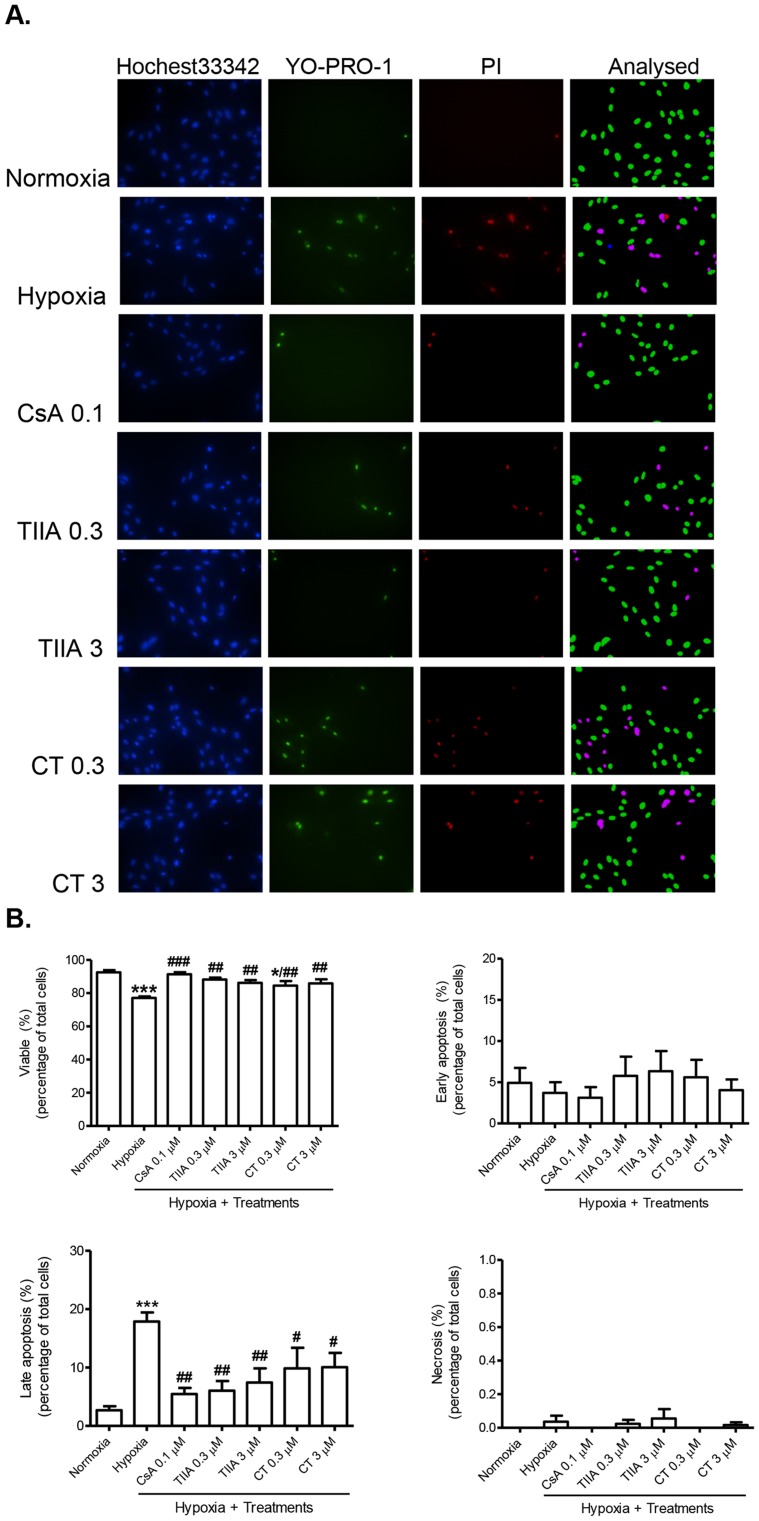
Effects of TIIA, CT and cyclosporin A (CsA) on hypoxia induced apoptosis. (A) Representative cell images from H9c2 cells staining with Hoechst 33342 (blue), YO-PRO-1 (green) and PI (red) as described in method. Analysed images show viable (green), early apoptosis (blue), late apoptosis (pink) and necrosis (red) cells respectively. (B) Mean data show subpopulations of viable cells (Hoechst 33342+), early apoptotic cells (Hoechst 33342+ and YO-PRO-1+), late apoptotic cells (Hoechst 33342+, YO-PRO-1+, PI+) and necrotic cells (Hoechst 33342+ and PI+) respectively. Values shown are mean ± SEM from n = 5. * P<0.05 vs. normoxia, # P<0.05 vs. hypoxia, ## P<0.01 vs. hypoxia, *** P<0.001 vs. normoxia, ### P<0.001 vs. hypoxia.